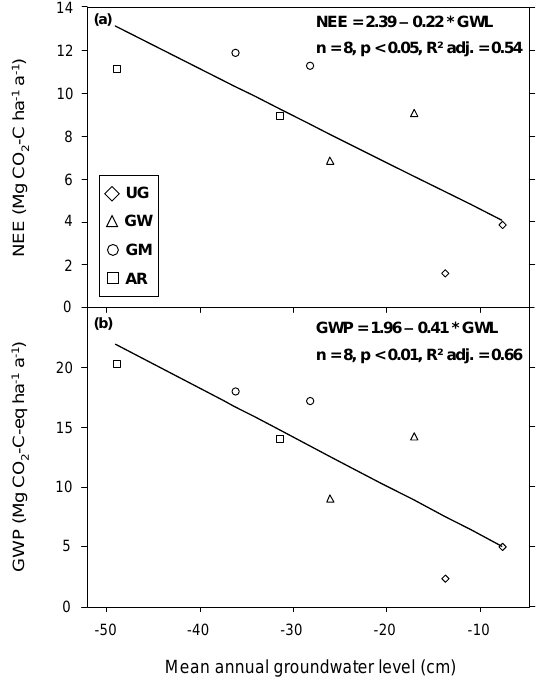
Figure 11. Relationship of mean annual amount of nitrate in 0– 20cm soil depth to mean annual groundwater level (a) and rela- tionship of mean annual N 2 O balances to mean annual amount of nitrate in 0–20cm soil depth (b) . GWL in the equation (a) is the mean annual groundwater level (cm), NO 3 –N in (b) is the mean annual amount of nitrate in 0–20cm (kgNha − 1 ) .